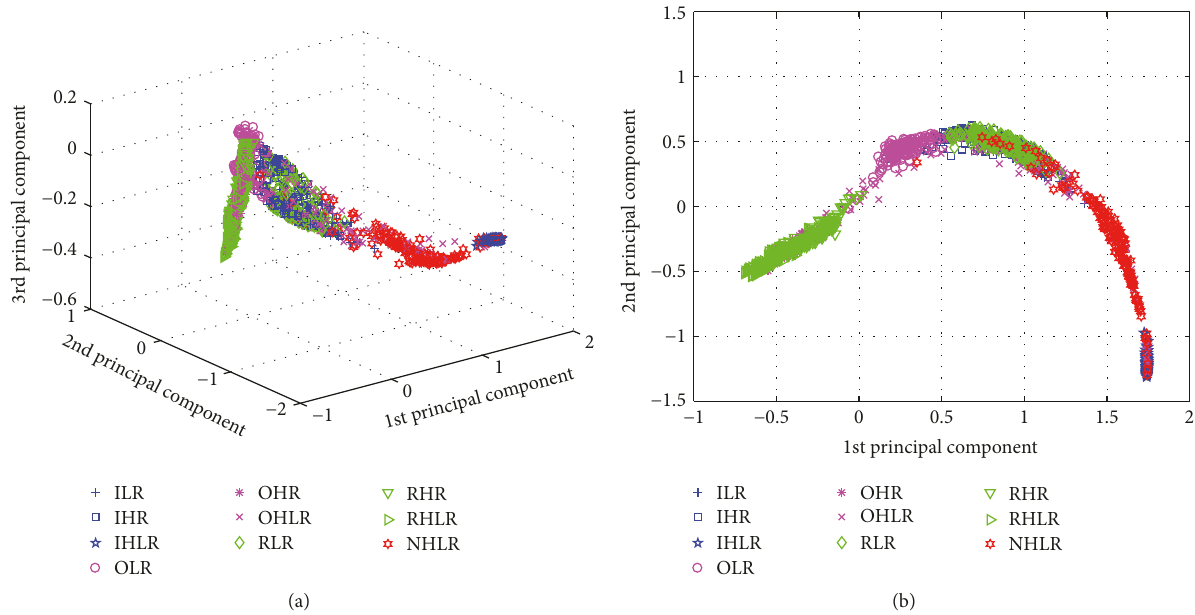
Figure 11: Feature visualization maps of standard SAE in Experiment 1. (a) The first three PCs; (b) the first two PCs.